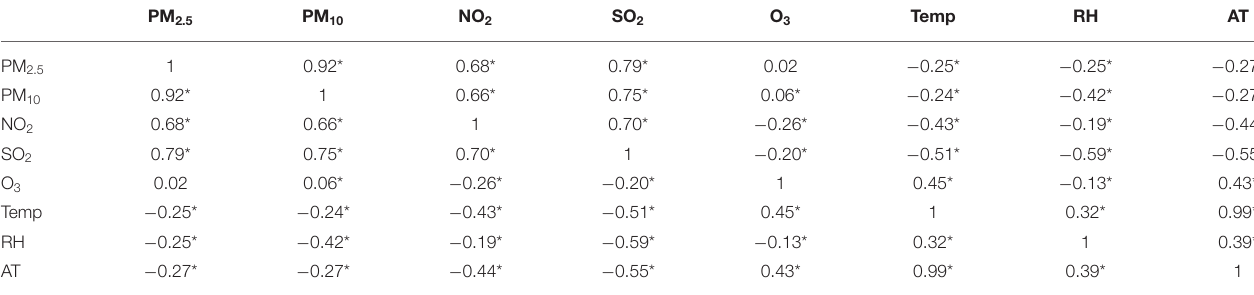
TABLE 3 | Spearman’s correlation coefficients between exposure